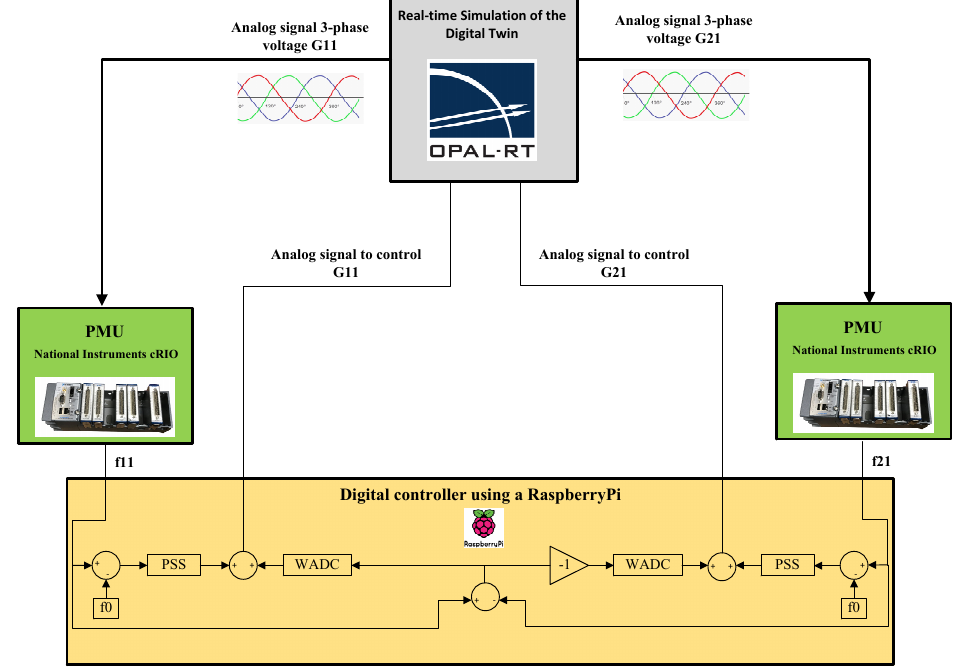
Figure 12. Schematic drawing of the HIL setup including the real time simulator, PMUs and the digital